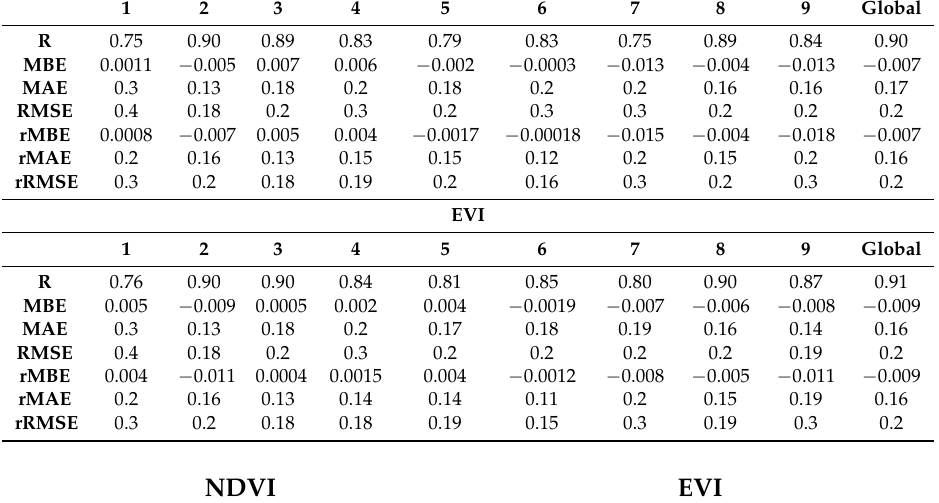
Figure 5. The model underestimates the annual GPP in the lighter peixls when using NDVI.